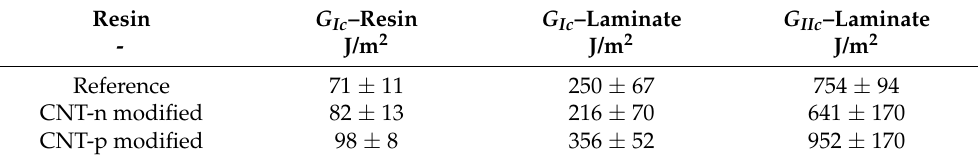
Table 2. Strain energy release rates of MWCNT-modified epoxy nanocomposites and prepreg laminates. CNT content is 0.5 wt.% for both types of CNTs.